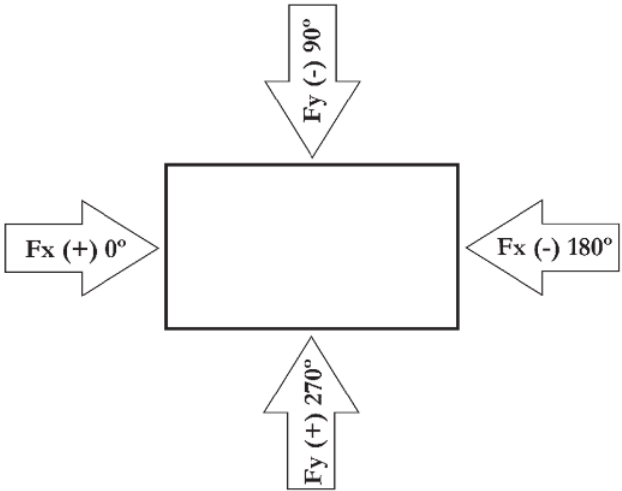
Principal directions considered for the lateral wind